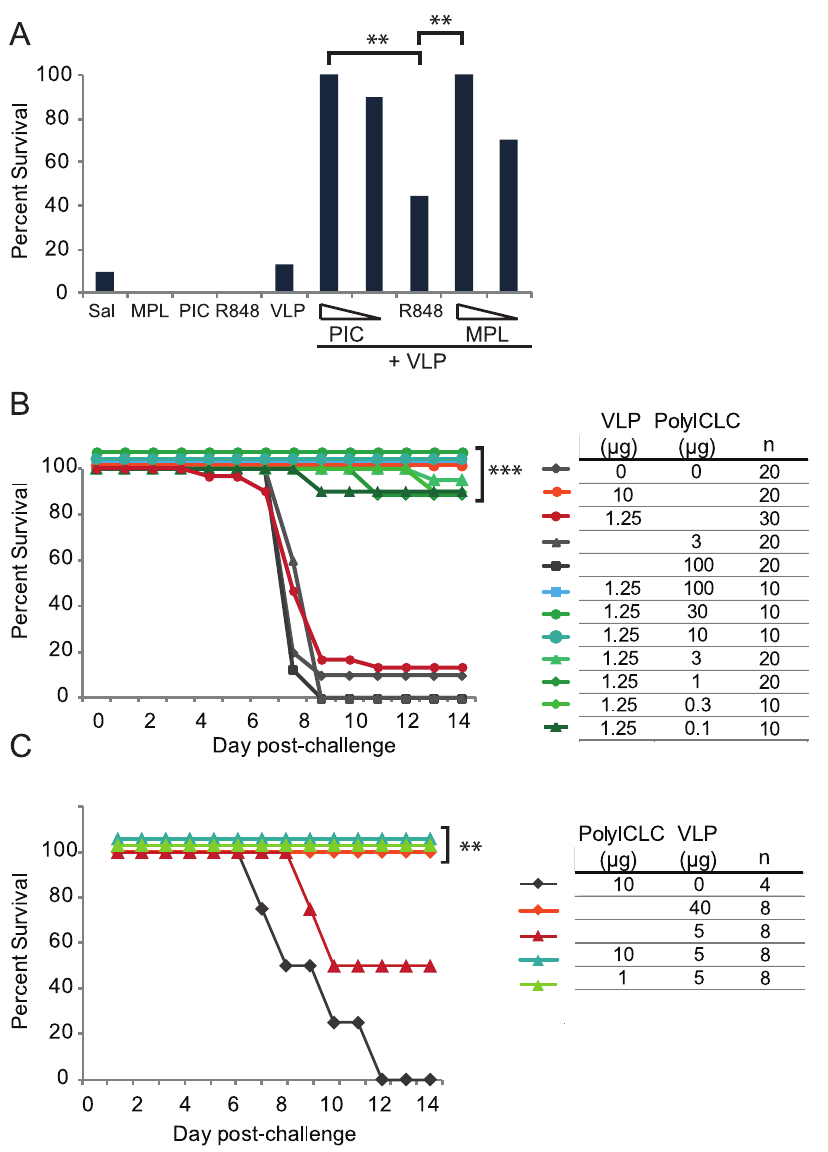
Figure 1. PolyICLC augments VLP-mediated protection from ma-EBOV and gp-adapted-EBOV challenge. C57BL/6 mice were vaccinated IM twice, three weeks apart, with 1.25 m g of VLP with or without 10 or 1 m g of polyICLC (PIC), 10 m g of R848, or 10 or 1 m g of MPL (A) or with dose levels of polyICLC ranging from 100 m g to 100 ng; ‘‘Sal’’ indicates Saline vaccination (B). Challenge occurred four weeks after the vaccine boost. (C) Hartley guinea pigs were vaccinated two times, three weeks apart, with 5 m g of VLP, with or without 10 m g or 1 m g of polyICLC. Nine or ten animals received R848 or MPL as adjuvant, respectively (A); polyICLC groups were repeated and the n is noted in (B). All p-values were calculated using Fisher’s exact test with multiple testing corrections performed by permutation based on the number of comparisons performed. Significant comparisons between vaccinations with 10 or 1 m g of adjuvant (A) or between the low dose group (red lines for both A and B) and the low dose group in combination with polyICLC (B and C) are shown. ‘‘***’’ indicates p , 0.0005 and ‘‘**’’ indicates p ,